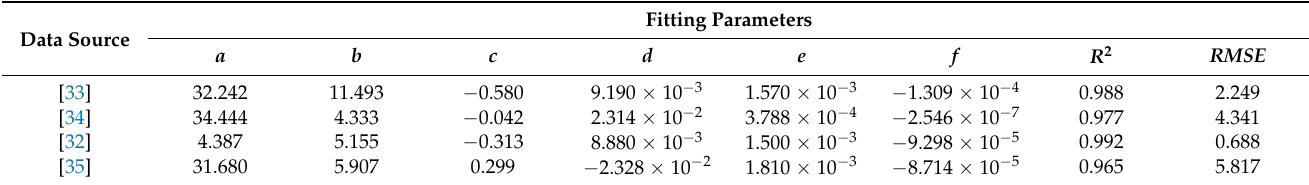
Figure 15. Fitting results of TCS of rocks for different quantities of F&T weathering cycles and different confining pressures: ( a ) from [33]; ( b ) from [34]; ( c ) from [32]; ( d ) from [35]. Table 4. Fitting parameters of the strength evolution model of rock specimens from the published